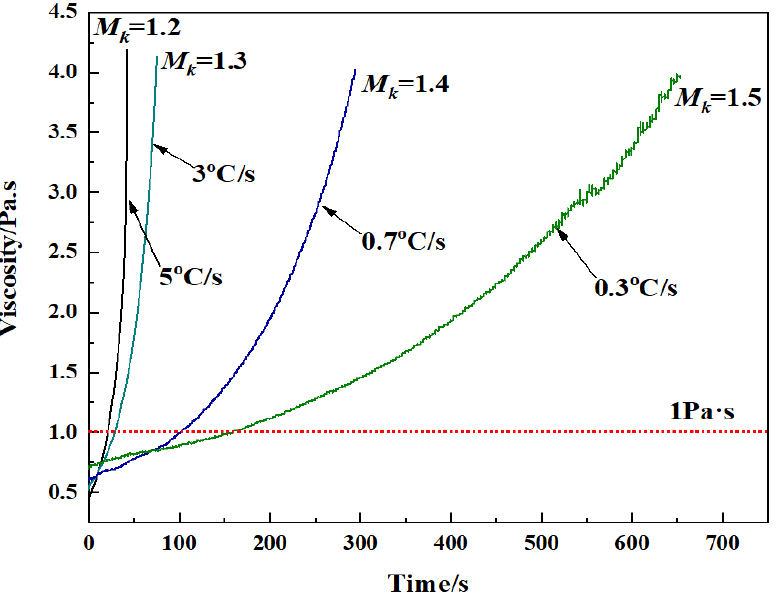
Figure 10. The corresponding hardening speed curves and viscosity–time curves for the modified blast furnace slag melt with different M k values cooled at its critical cooling rate.